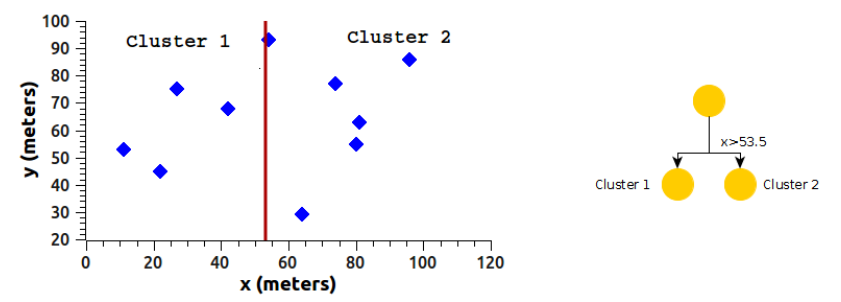
Figure 5. k-d tree algorithm with x -dimension.